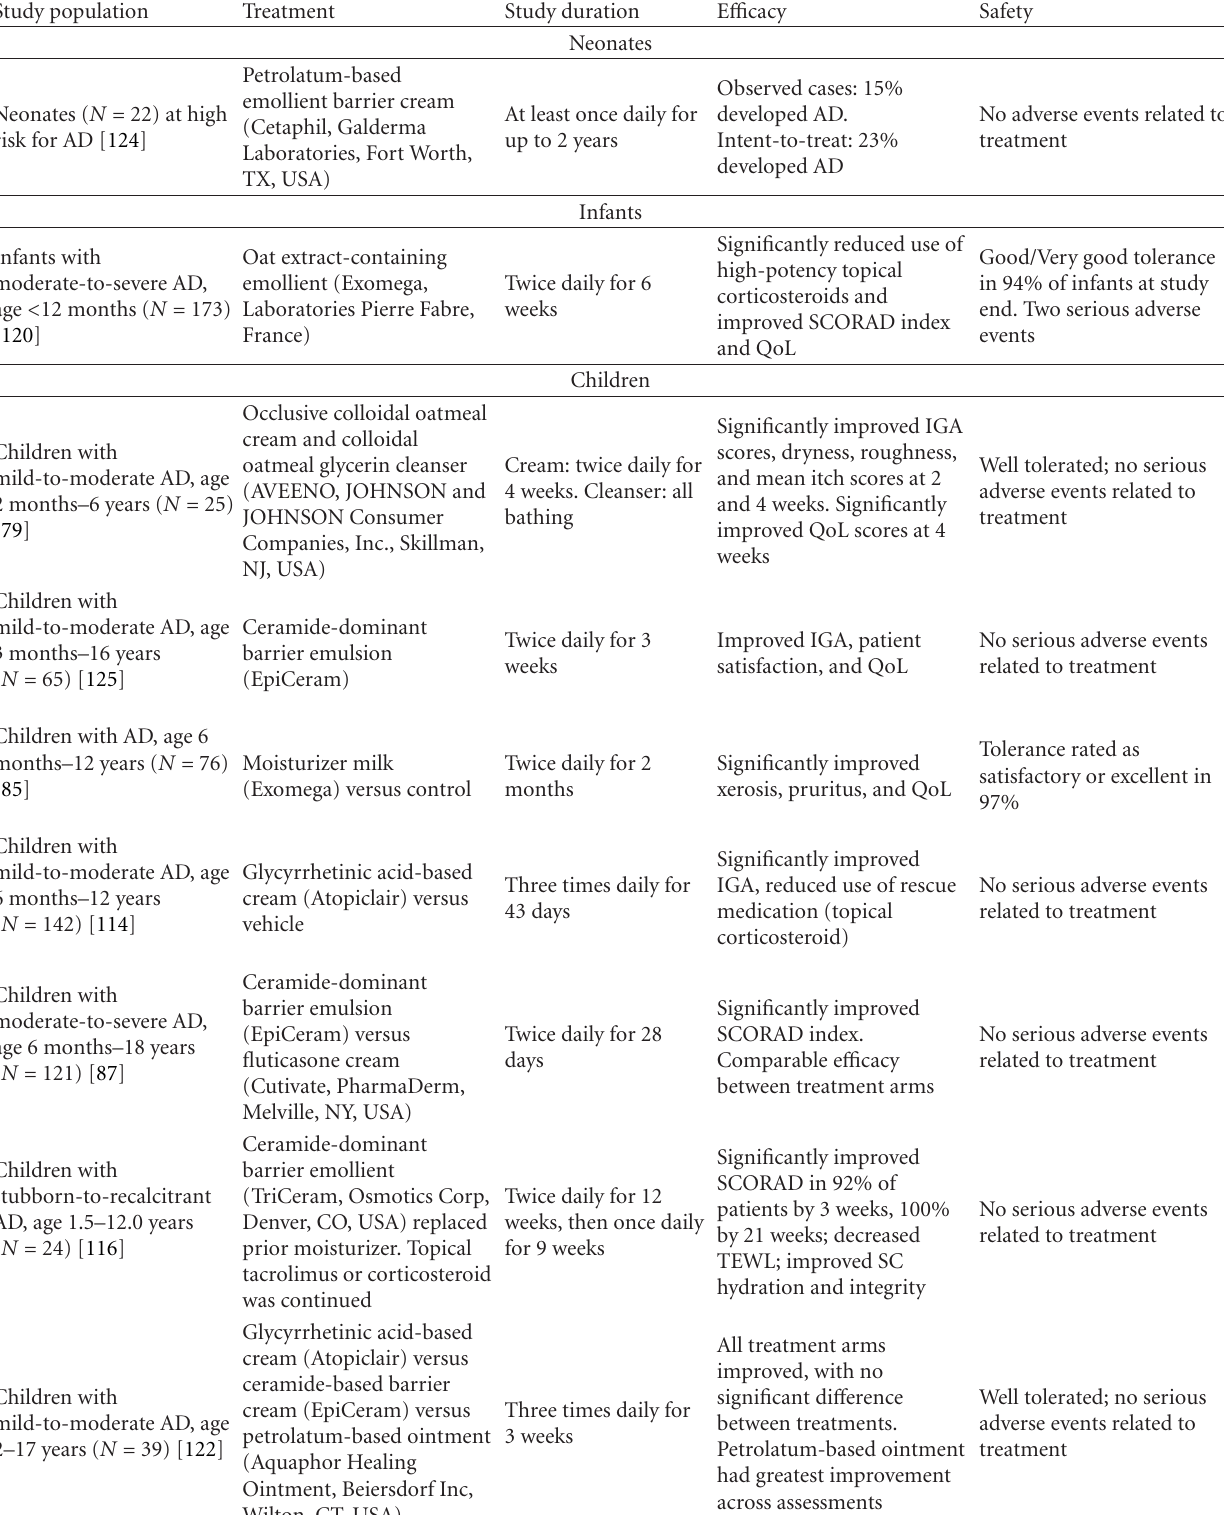
Table 2: Summary of studies of emollient use in neonates, infants, children, and adults with